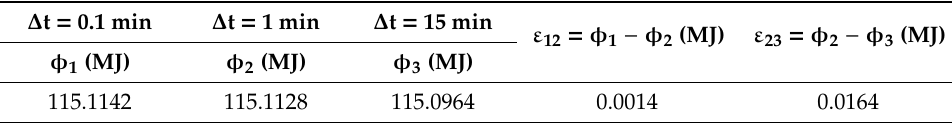
Table 6. Data of the time step independence study for the conduction energy gain variable during the heating process.